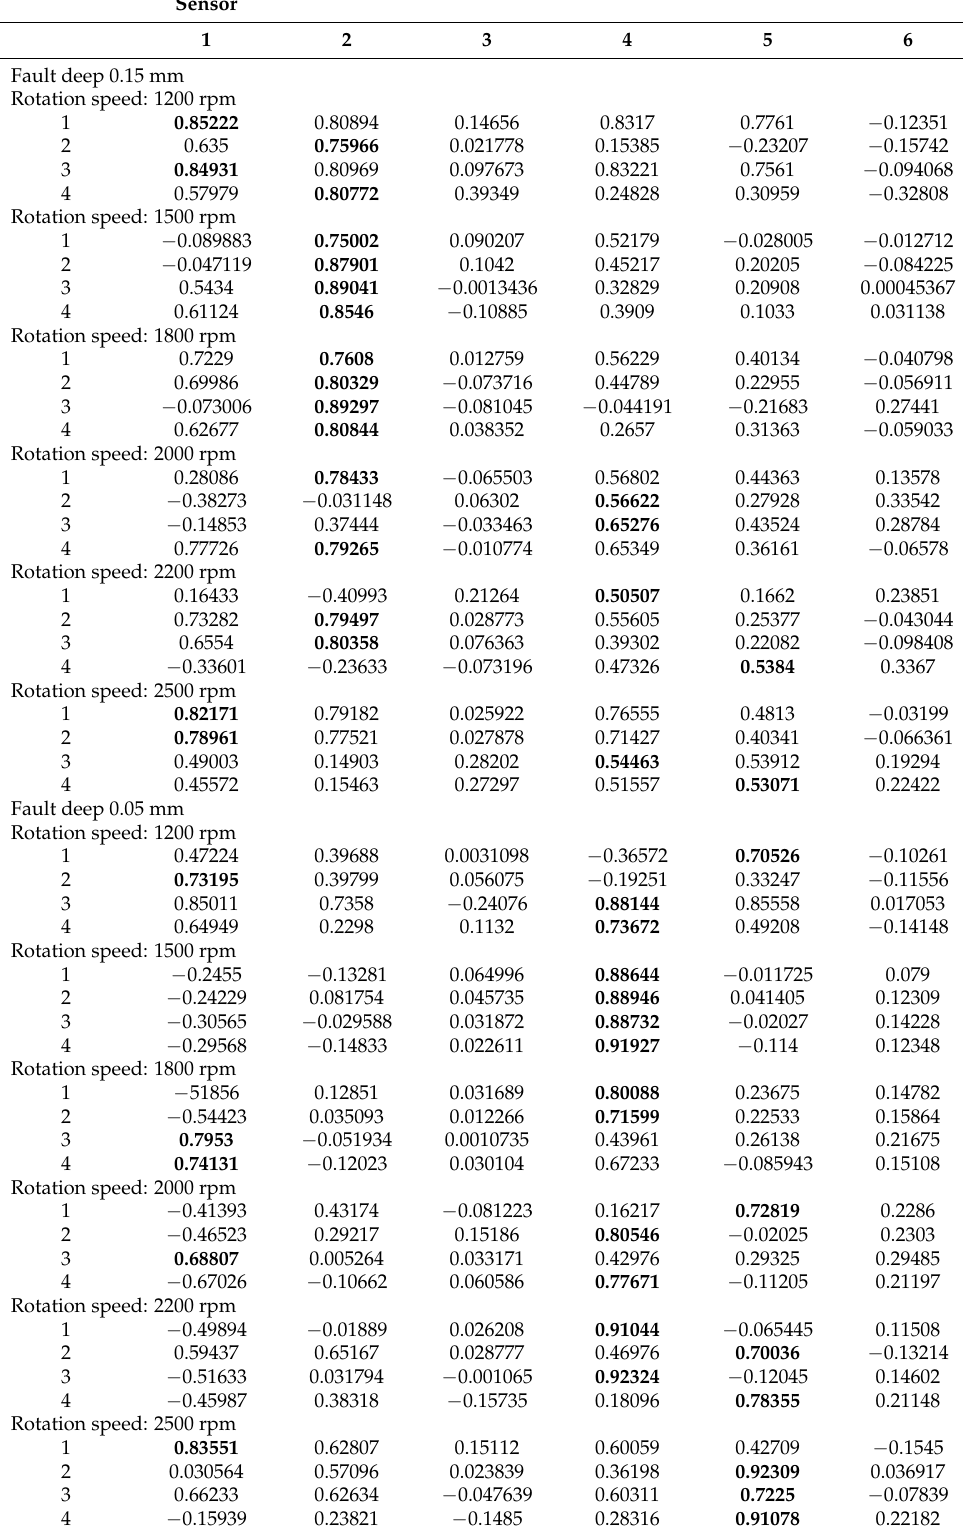
Table 4. Data management of correlation coefficients for signal contrast (Outer race